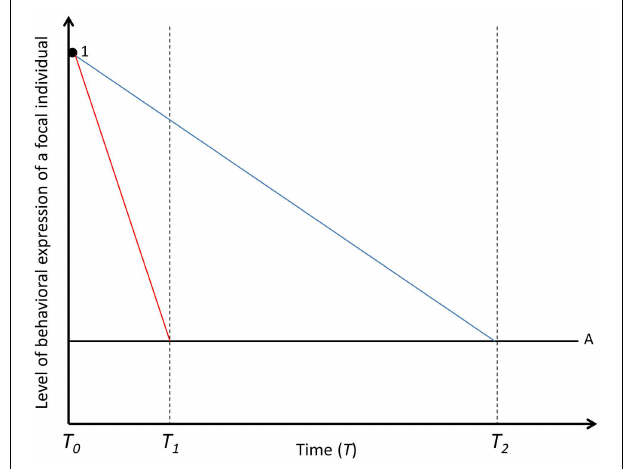
FIGURE 1 | Decay of the social carry-over effect on behavioral expression of a focal individual in time. The solid black line represents the focal individual’s (A) baseline level of behavioral expression, while red, and blue lines represent the behavioral expression of a focal individual under social carry-over effects by social partner (round black dot; 1). Carry-over effects are underpinned by either fast-changing (red line) or slow-changing (blue line) state variables. The social partner effect is decayed in T 1 if underpinned by fast-changing mechanisms and in T 2 if underpinned by slow-changing mechanisms. The social interaction is terminated in T 0 . For simplicity, the partner effects, driven by fast- and slow-changing states are assumed to be the same magnitude in T 0